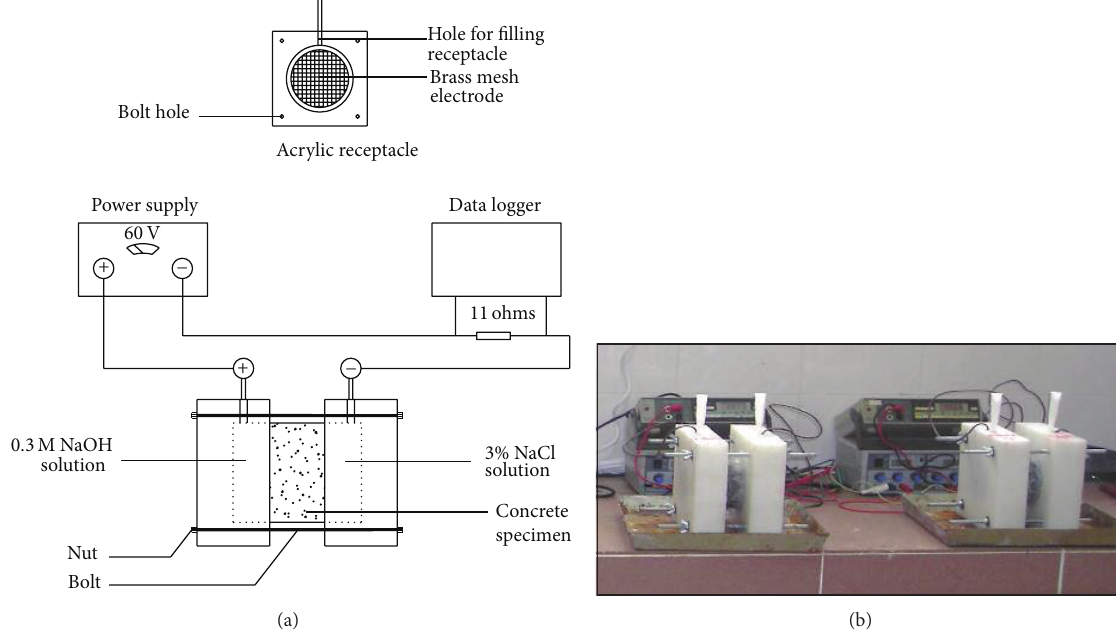
Figure 2: RCPT test setup: (a) schematic presentation of the test setup for RCPT and (b) photographic view of the RCPT test setup.